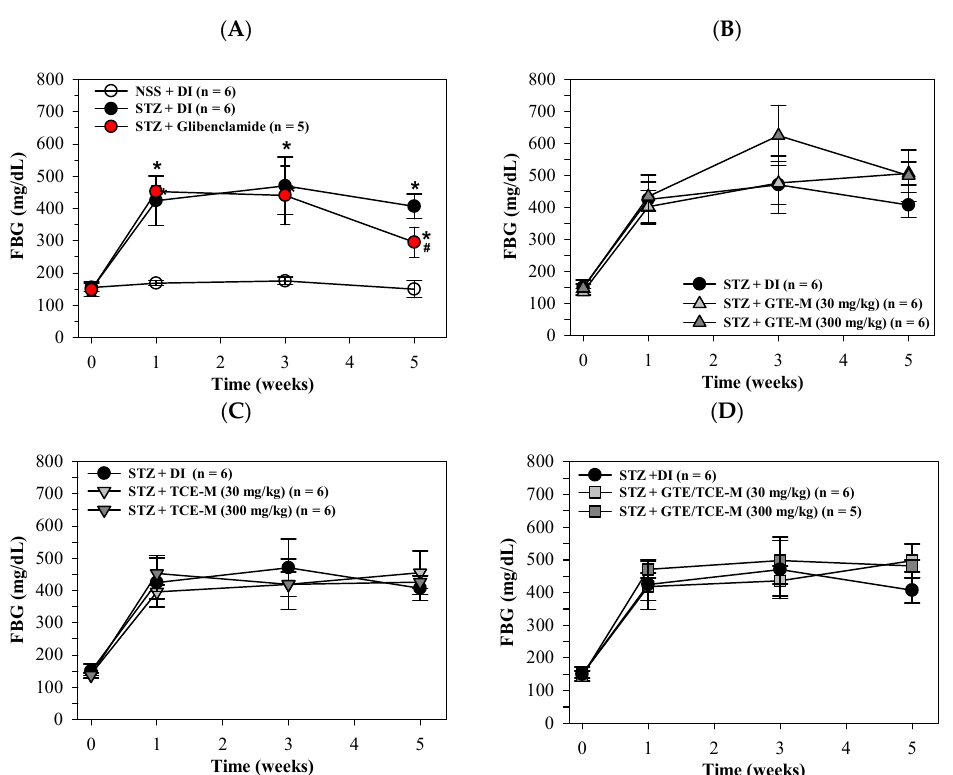
Figure 2. Serum levels of FBG in STZ-induced rats intervened with macaroni products. Rats were i.p. injected with STZ (65 mg/kg, single dose) to induce diabetic mellitus and administered p.o. with DI, glibenclamide (5 mg/kg) ( A ), GTE-M ( B ), TCE-M ( C ) or GTE/TCE-M ( D ) macaroni products (30 and 300 mg/kg each) every day for four weeks. Data are expressed as mean ± SD values. Accordingly, * p < 0.05 when compared with NSS + DI at the same time; while # p < 0.05 when compared with STZ + DI. Abbreviations: DI = deionized water, FBG = fasting blood glucose, GTE-M = green tea extract-fortified macaroni, GTE/TCE-M = green tea extract and turmeric curcumin extract-fortified macaroni, i.p. = intraperitoneally, NSS = normal saline solution, p.o. = per oral, STZ = streptozotocin and TCE-M = turmeric curcumin extract-fortified macaroni.